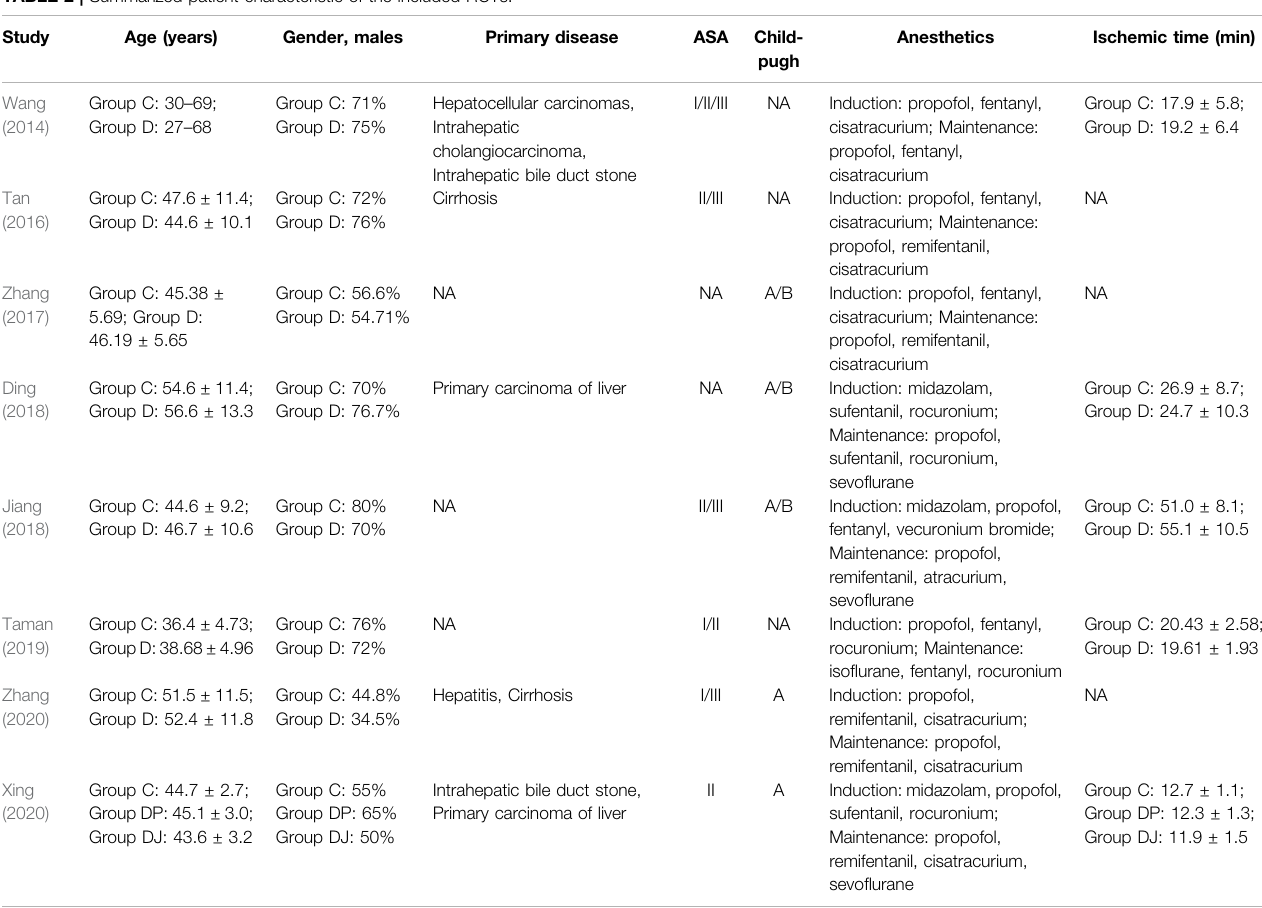
TABLE 2 | Summarized patient characteristic of the included